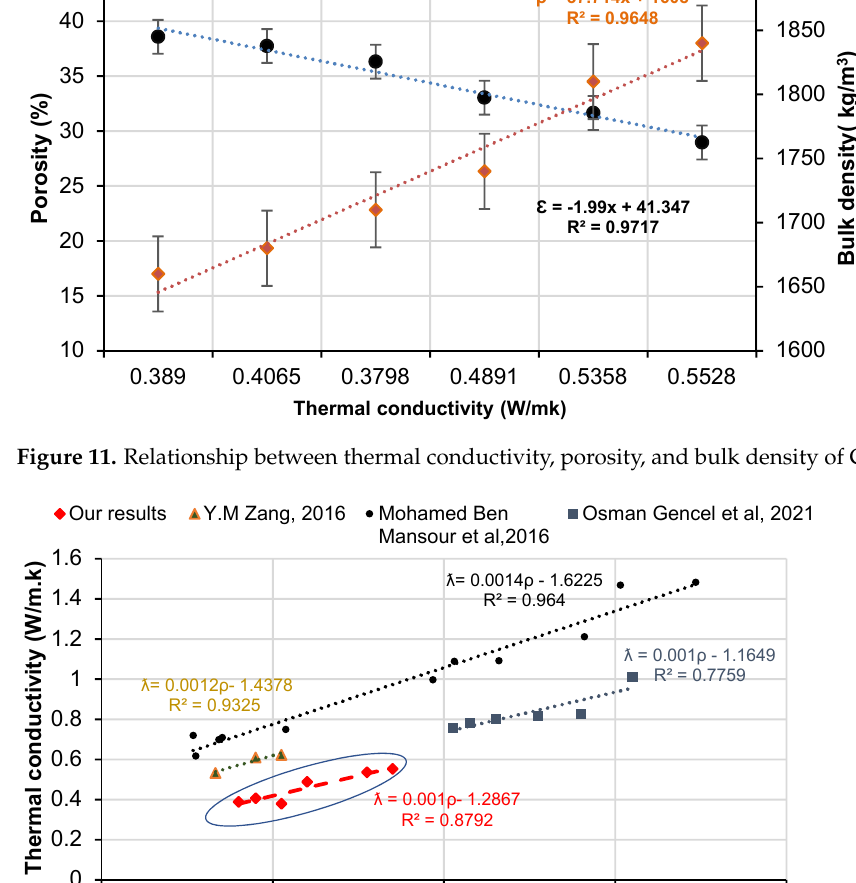
Figure 8. Relationship between thermal conductivity, porosity, and bulk density of CEBs.